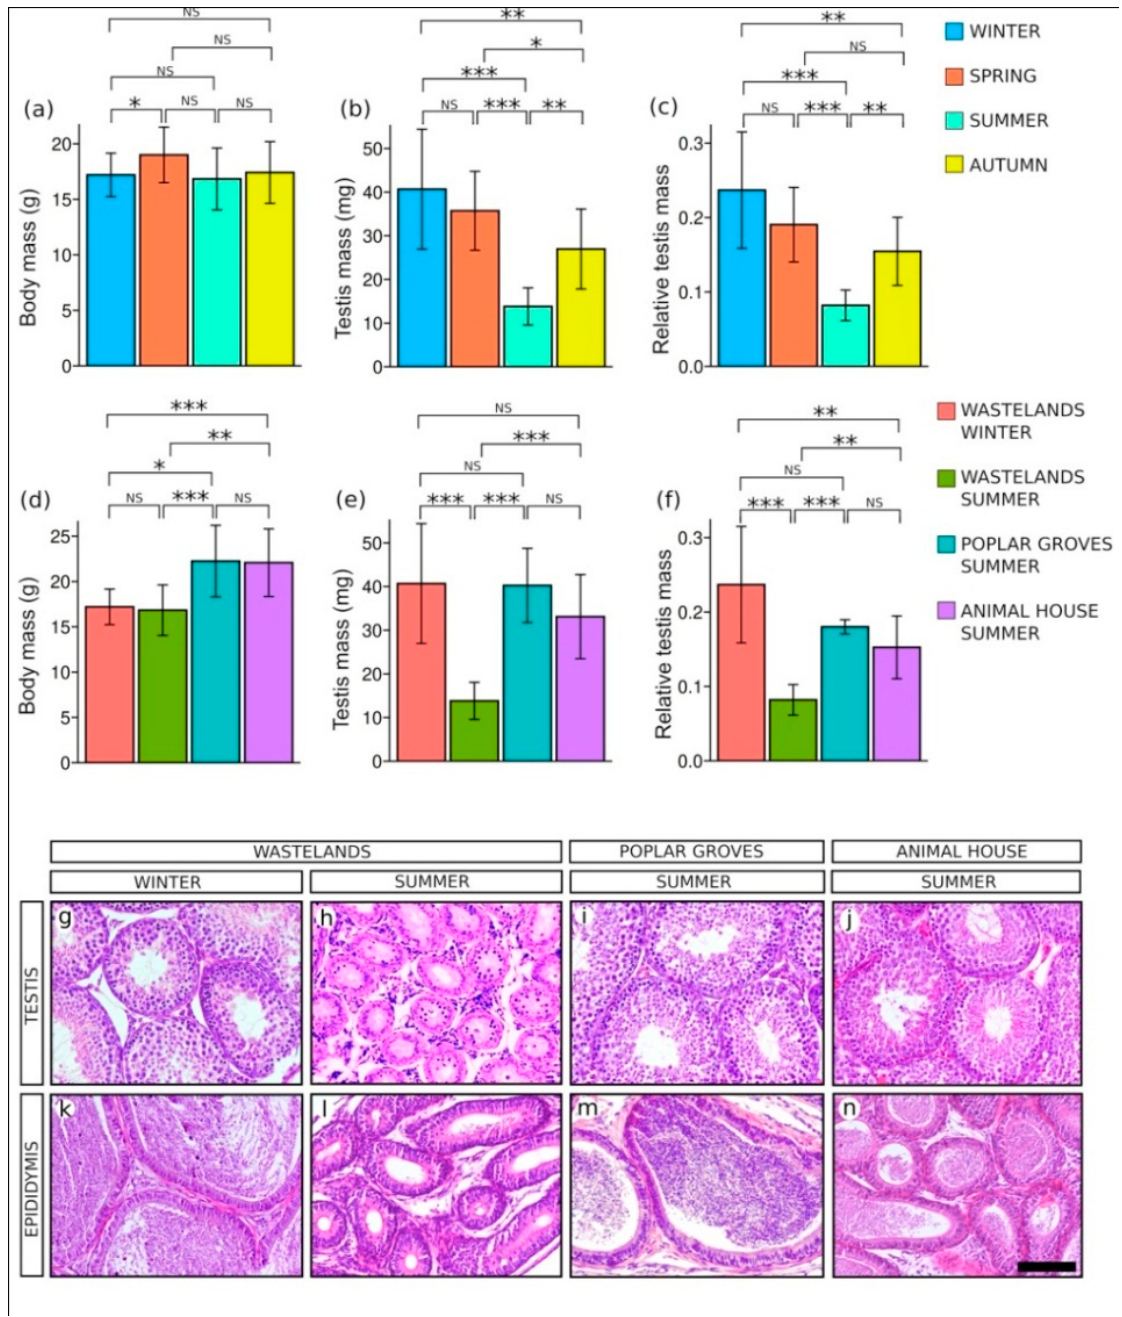
Figure 1. Morphometric analysis ( a – f ) and histology of testes and epididymes ( g – n ) of M. duodecimcostatus during the seasonal reproductive cycle. ( a – c ) Comparisons of ( a ) body mass, ( b ) testis mass and ( c ) relative mass of the testis of voles captured in the wastelands during the seasonal breeding cycle. ( d – f ) Comparisons of ( d ) body mass, ( e ) testis mass and ( e ) relative mass of the testis of voles living in different habitats. ( g – n ) Hematoxylin and eosin-stained histological sections of testes ( g – j ) and epididymides ( k – n ) of voles captured in the wastelands in winter ( g , k ), captured in the wastelands in summer ( h , l ), captured in poplar groves in summer ( i – m ) and living in our animal house facility during the summer ( j , n ). Scale bar shown in ( n ) represents 100 μ m for all pictures. NS, not significant; *, p < 0.05; **, p < 0.005; ***, p < 0.001.